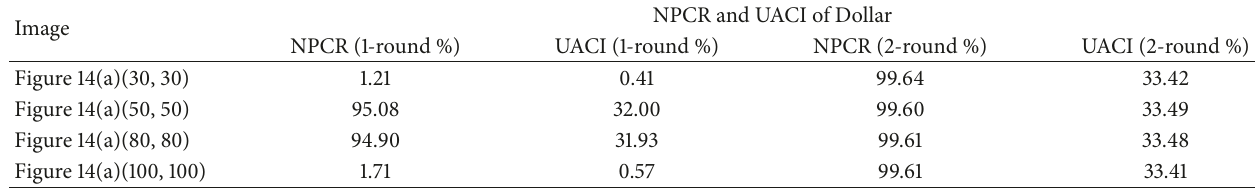
Table 11: NPCR and UACI between cipher-images with slightly different plain-images.